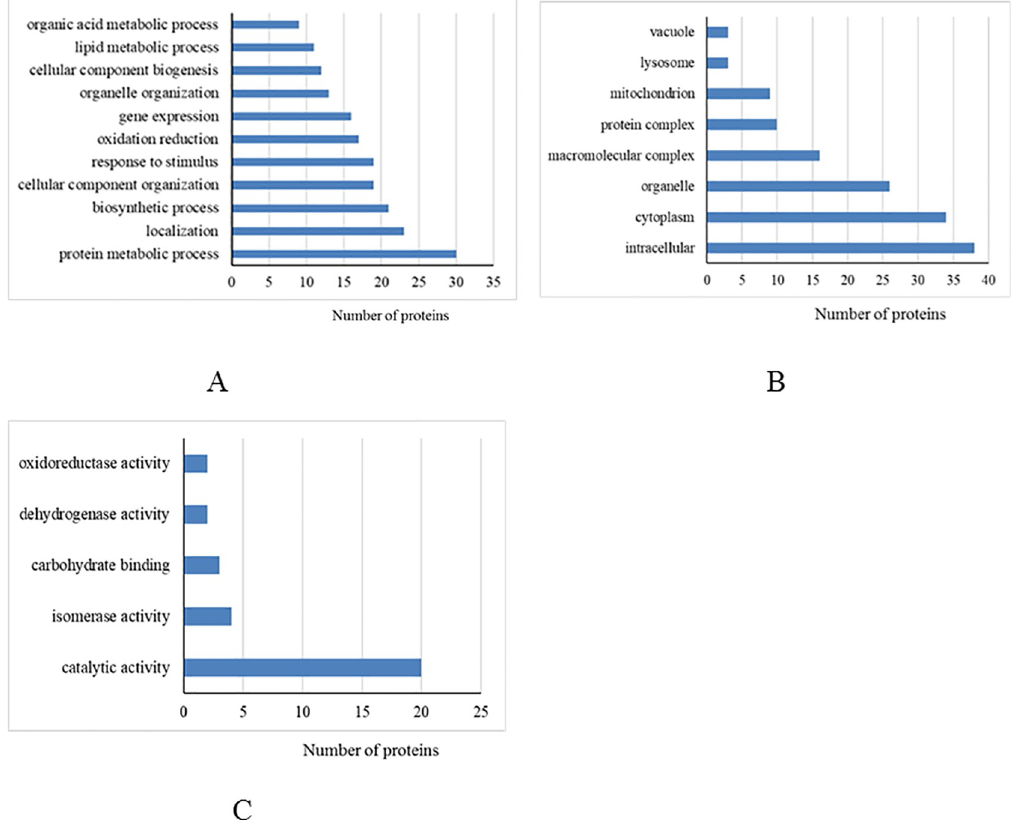
Fig 2. Differentially expressed proteins from mammary gland between heat-stressed and pair-fed control cows grouped into biological process (A), cellular component (B) and molecular function (C) based on David bioinformatics resources.